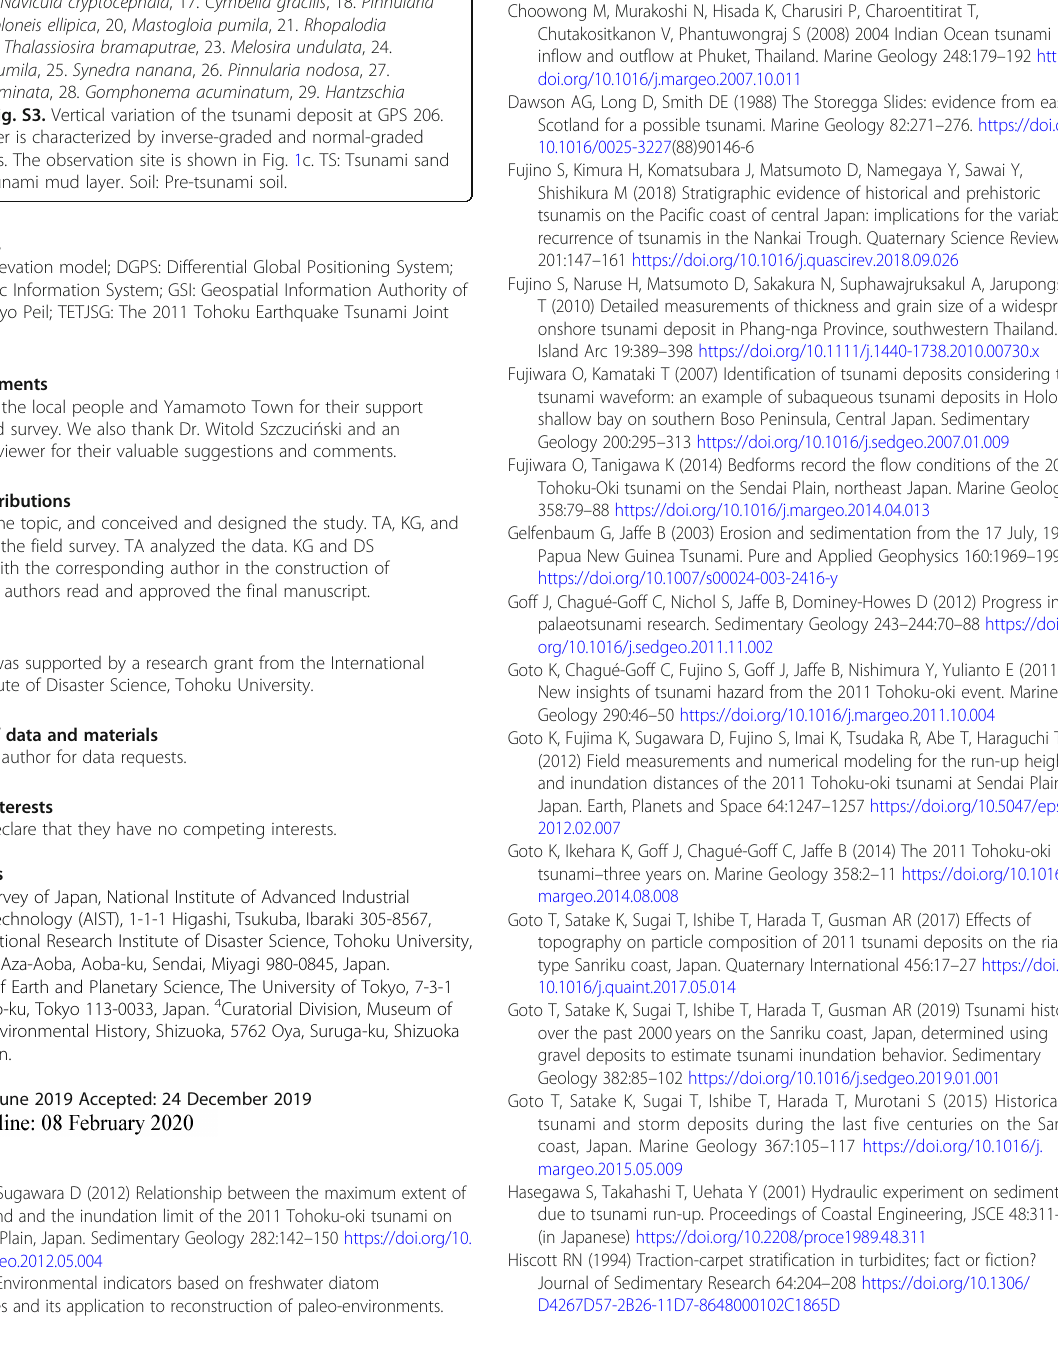
Table S2. Results of analysis of diatom assemblage. Only the common species are presented. The sampling sites are shown in Fig. 1c. Additional file 2: Fig. S1. Oblique aerial photographs in our study area taken by The Geospatial Information Authority of Japan on May 25, 2011. (A) View from offshore. (B) View from valley head. Fig. S2. Examples of diatom species in the muddy deposits: 1. Fragilaria pinnata , 2. Navicula salinarum , 3. Rhopalodia operculata , 4. Navicula cincta . 5. Cyclotella meneghiniana , 6. Hyalodiscus scoticus , 7. Aulacoseira distans , 8. Synedra tabulata , 9. Nitzschia plana , 10. Neidium alpinum , 11. Pinnularia gibba , 12. Nitzschia calida , 13. Navicula elegans , 14. Navicula radiosa , 15. Navicula crucicula , 16. Navicula cryptocephala , 17. Cymbella gracilis , 18. Pinnularia viridis , 19. Diploneis ellipica , 20, Mastogloia pumila , 21. Rhopalodia gibberula , 22. Thalassiosira bramaputrae , 23. Melosira undulata , 24. Mastogloia pumila , 25. Synedra nanana , 26. Pinnularia nodosa , 27. Nitzschia acuminata , 28. Gomphonema acuminatum , 29. Hantzschia amphioxys . Fig. S3. Vertical variation of the tsunami deposit at GPS 206. The sand layer is characterized by inverse-graded and normal-graded multiple units. The observation site is shown in Fig. 1c. TS: Tsunami sand layer. TM: Tsunami mud layer. Soil: Pre-tsunami